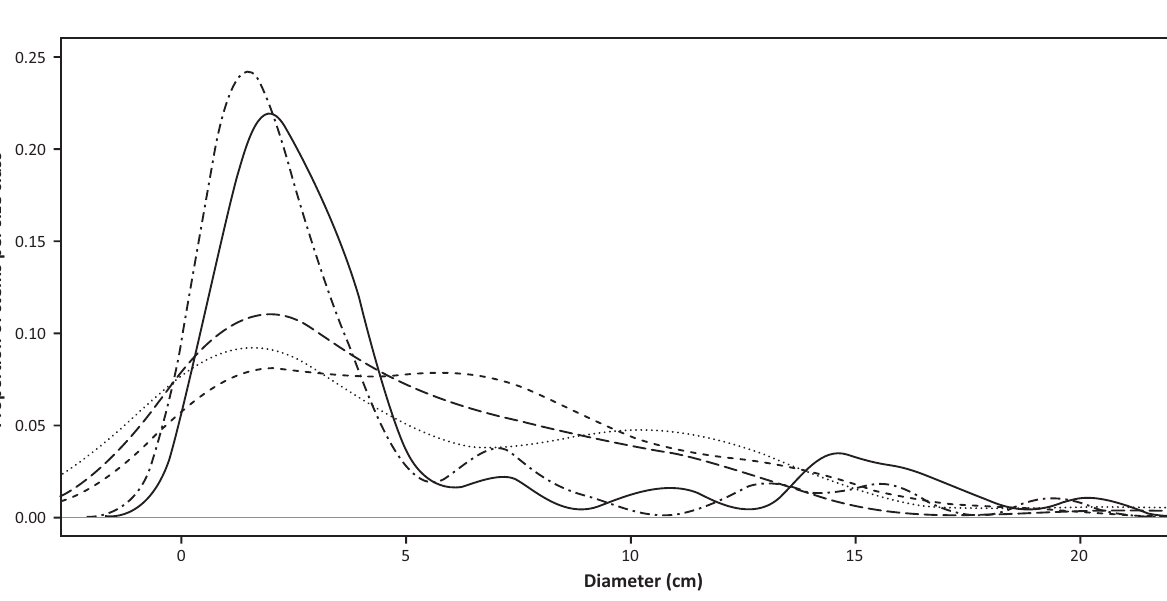
Figure 8 continues on the next page